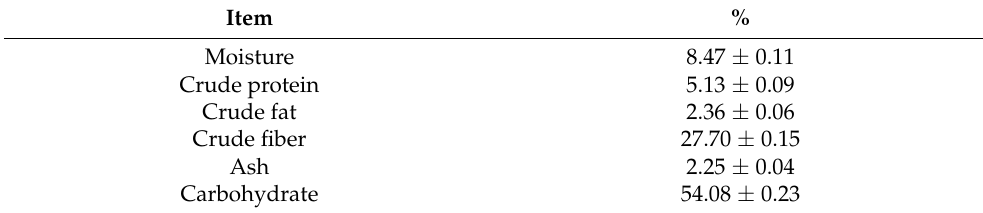
Table 1. Proximate composition of date press cake on a wet weight